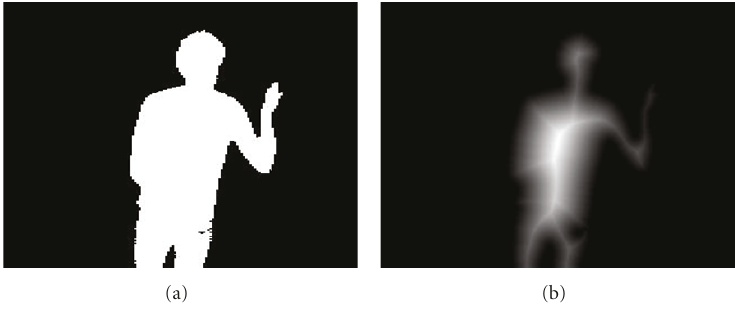
Figure 4: Image supports: (a) silhouette; (b) euclidean distance